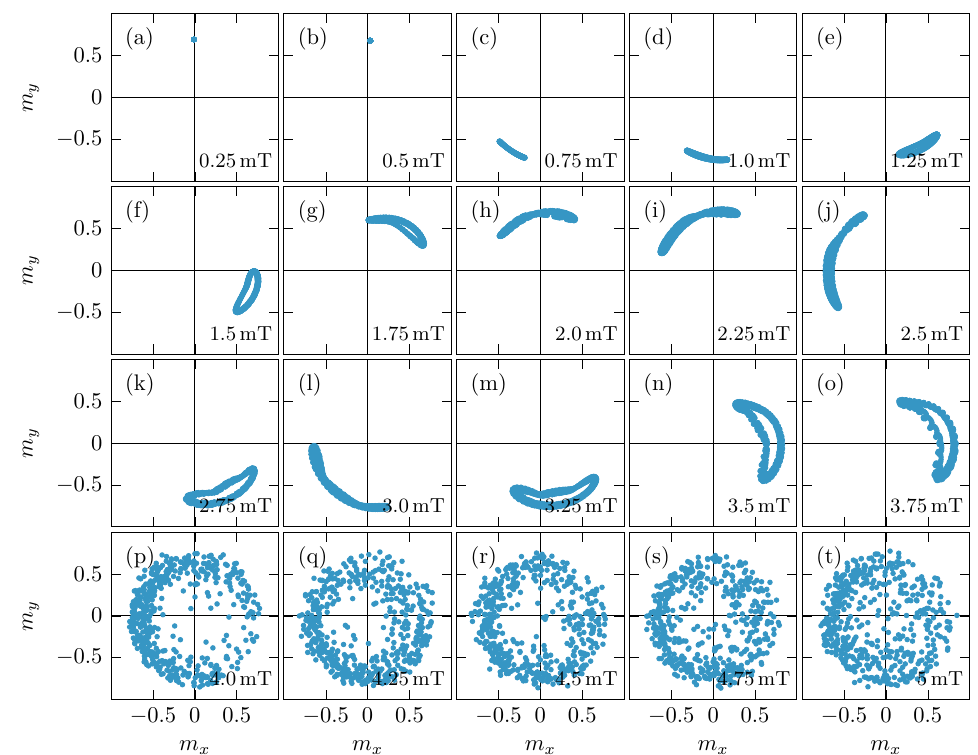
Figure 10: Projection of a single spin m onto the x y plane recorded stroboscopically = 2 π n / ( ω − Ω ) , n ∈ (cid:78) , and rotated by − Ω t at times t to eliminate the n n screw screw screw rotation. In each panel, the respective amplitude B x is given in mT. Param- ⊥ π eters are as in Fig. 8, for the system of size 15 2 . (a)–(b) In the regular regime, q within numerical precision a single point is obtained. (c)–(o) A closed orbit signals the presence of the time quasicrystal. (p)–(r) The onset of chaos manifests itself in aperiodic trajectories, covering a significant area of the configuration space. Close to the onset of chaos we also see signatures of higher order time quasicrystals, with extra oscillation frequencies (panel